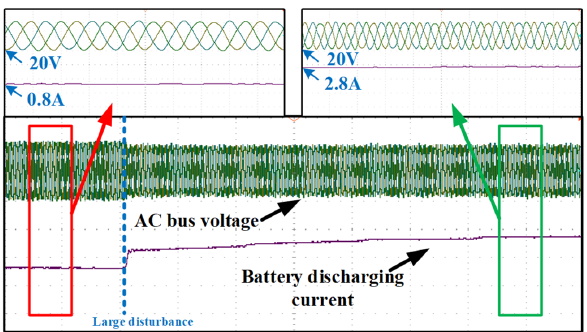
Figure 18. The curves of AC bus voltages and battery discharging current (Group A).